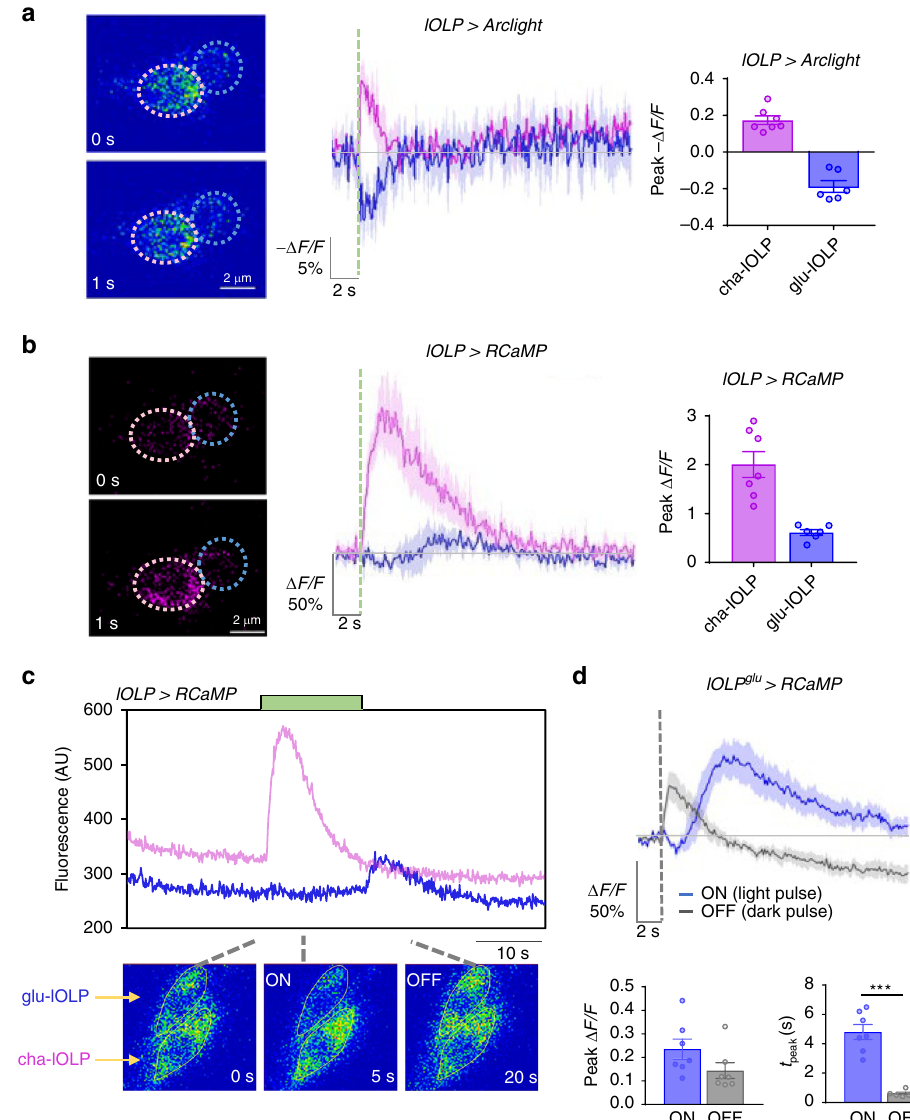
Fig. 3 Light activates cha-lOLP and inhibits glu-lOLP. a , b Optical recordings using the voltage sensor Arclight together with the calcium sensor RCaMP reveal light-induced depolarization and fast calcium transients in cha-lOLP (magenta) as well as hyperpolarization and delayed calcium transients in glu- lOLP (blue). Representative frames from the recordings (left), averaged traces (middle), and the quanti fi cation of peak values of the changed intensity ( Δ F / F ) (right) are shown. Scale bars and time are as indicated. Somatic regions used for quanti fi cation are marked by dashed circles. The dashed green line represents a 100 ms light pulse. cha-lOLP, n = 7; glu-lOLP, n = 6. c cha-lOLP exhibits ON responses, while glu-lOLP exhibits OFF responses. A representative raw trace from the lOLP > RCaMP recording is shown (top). The sample was subjected to an extended (12.5 s) light stimulation (green bar). cha-lOLP responded to the light onset, but not to the light offset. In contrast, the light onset induced a small reduction of calcium signal in glu-lOLP, while the light offset produced a rapid calcium rise. Representative frames of the recording are shown (bottom). d ON and OFF signals generate calcium transients with different temporal pro fi les in glu-lOLP. Average traces of calcium transients generated by recordings of lOLP glu -Gal4 driving RCaMP are shown, demonstrating the slow calcium response to the light pulse (ON response, blue) and the fast calcium response to the dark pulse (OFF response, gray). The response amplitudes were not signi fi cantly different. The average traces (top) and the quanti fi cation of peak value and peak time of changed intensity ( Δ F / F ) (bottom) are as shown. n = 7 in both groups. ON: p = 0.1205; OFF: p < 0.001. Shaded areas on traces and error bars on quanti fi cations represent SEM. The dashed line represents a 100 ms light or dark pulse. Statistical signi fi cance was determined by Student ’ s t test. p ≥ 0.05 was considered not signi fi cant, *** p < larval brain. Immunohistochemical studies using anti-ChAT and anti-VGluT antibodies con fi rmed that the mAchR-B receptor expresses in glu-lOLP, but not in cha-lOLP (Fig. 4b, c). Next, we performed transgenic RNA interference (RNAi) knockdown experiments targeting mAchR-B and recorded the lOLPs ’ response to 100 ms light vs. dark pulses using RCaMP to examine